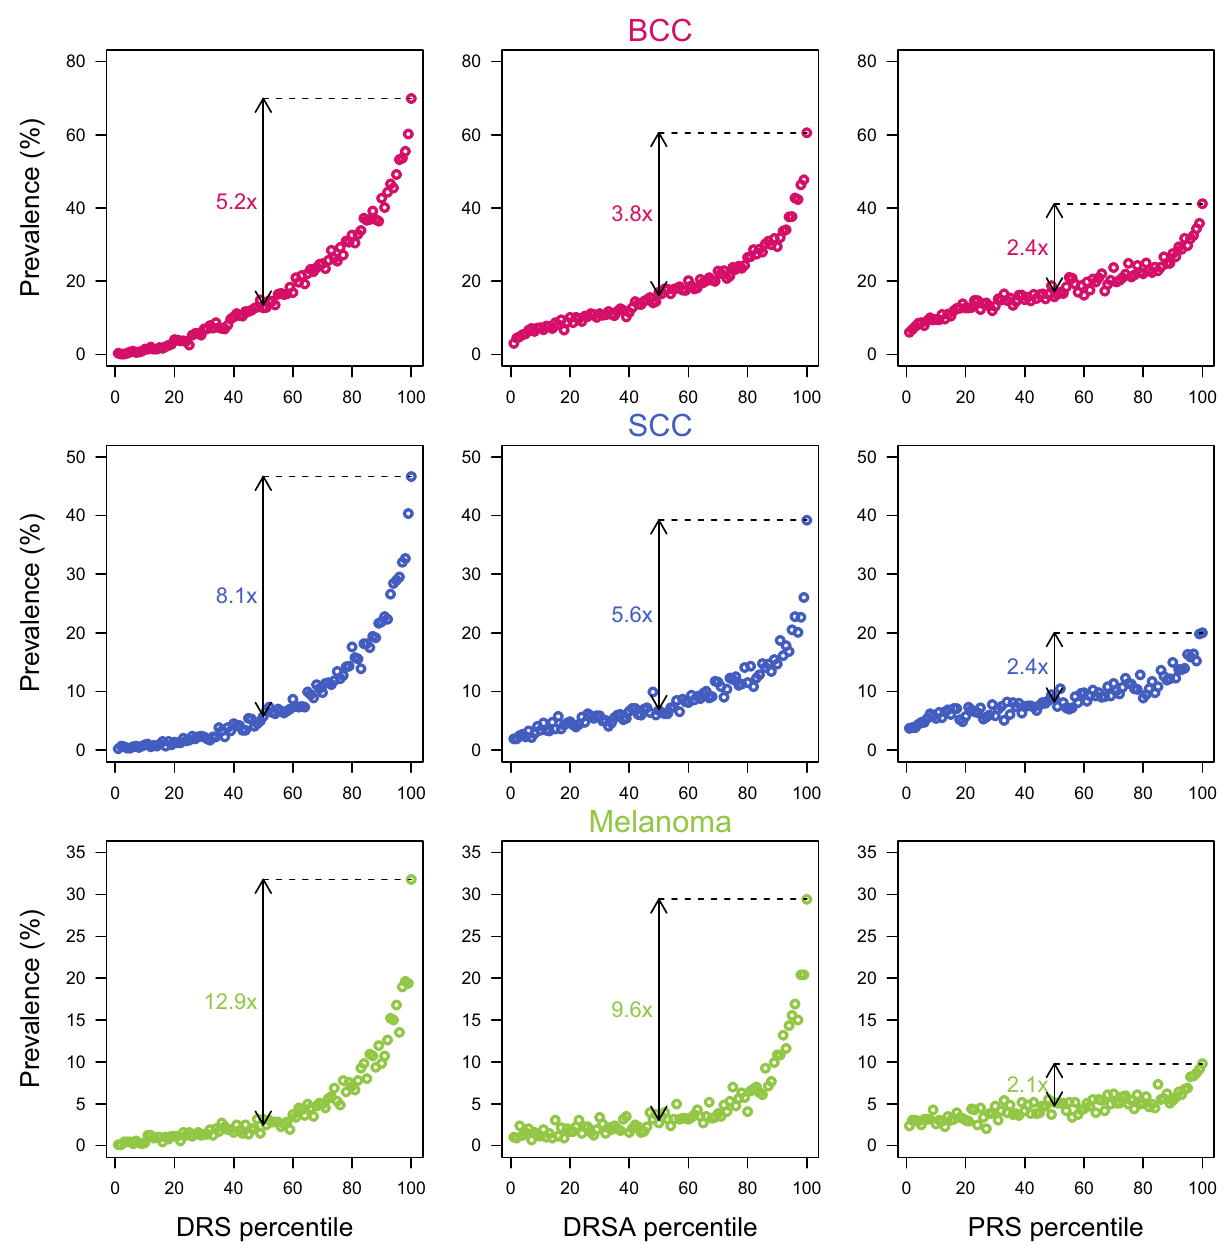
Fig. 3 Prevalence of skin cancer cases across the binned DRS, DRSA, and PRS distributions in the validation set. Risk score distributions are binned into percentiles. Each bin contains 890 participants. The prevalence is the percentage of participants reporting skin cancer in each